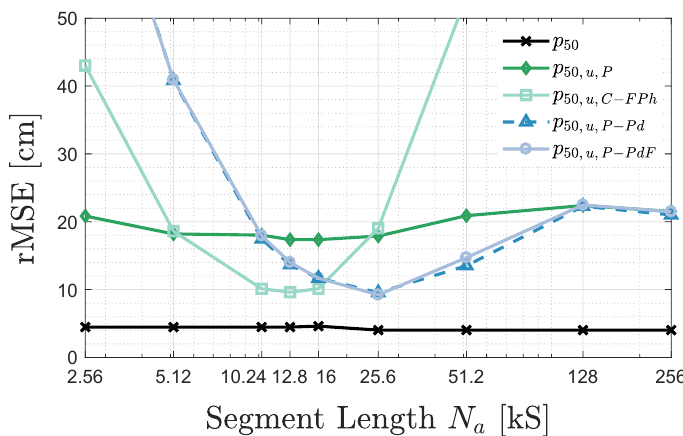
Figure 13. Influence of the sample size N a on the p 50 of MBFB for VLP (in black) and for uVLP PEAK, C-FPh, P-Pd and